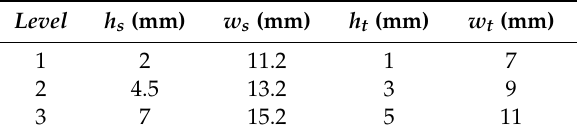
Figure 8. Schematic diagram of machine tooth profile parameters. Table 1. Tooth profile optimization parameter levels.